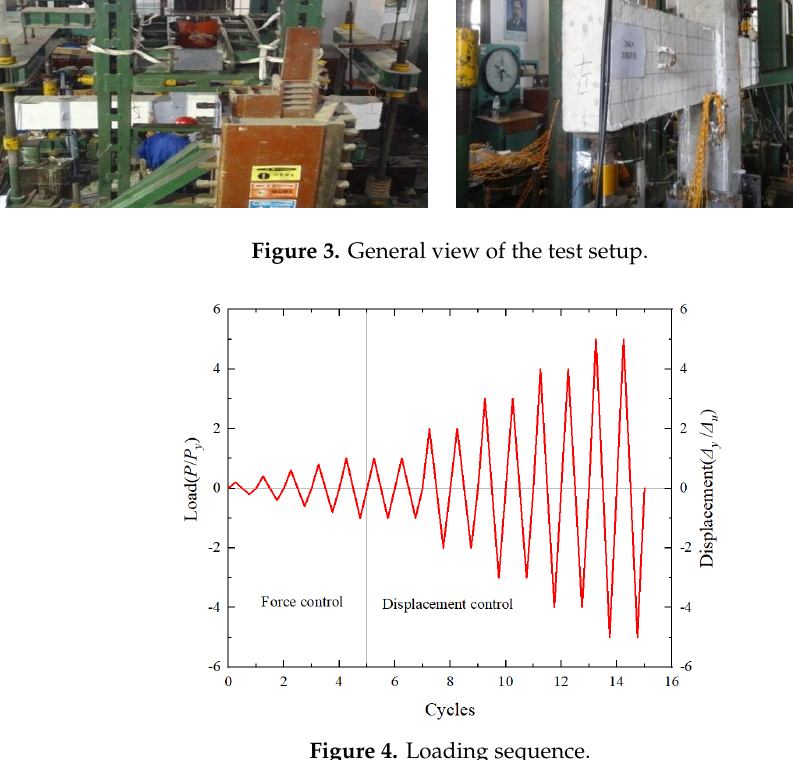
Figure 4. Loading sequence.